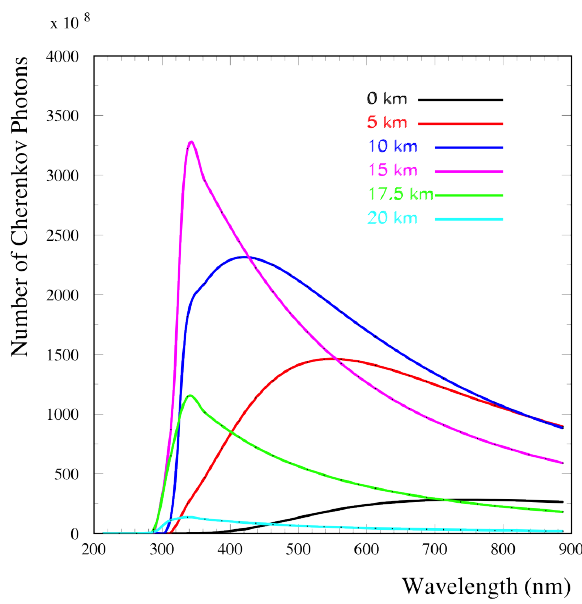
Figure 12. The intensity and wavelength dependence of the Cherenkov signal for 100 PeV upward-moving EASs for 5 ◦ Earth emergence angle as a function of EAS starting altitude. From Ref. [20].